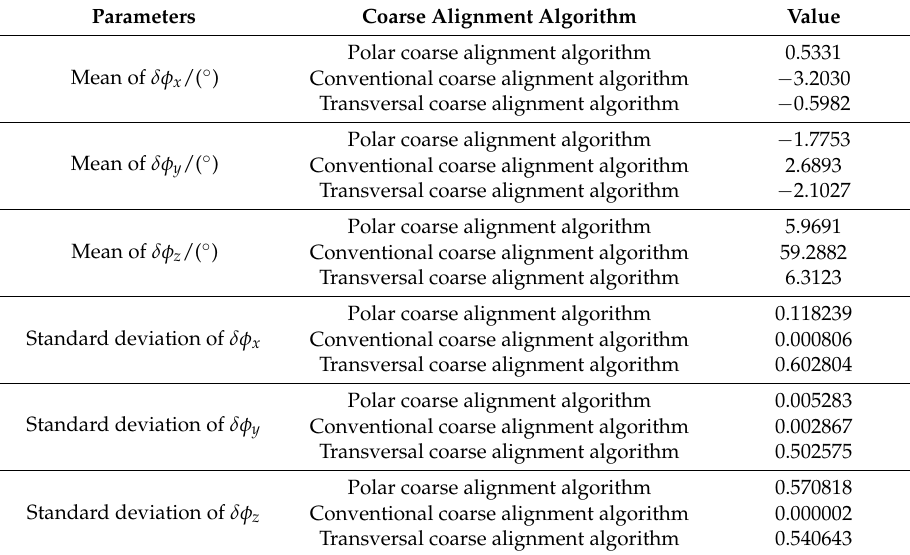
Table 2. The simulation results of coarse alignments.